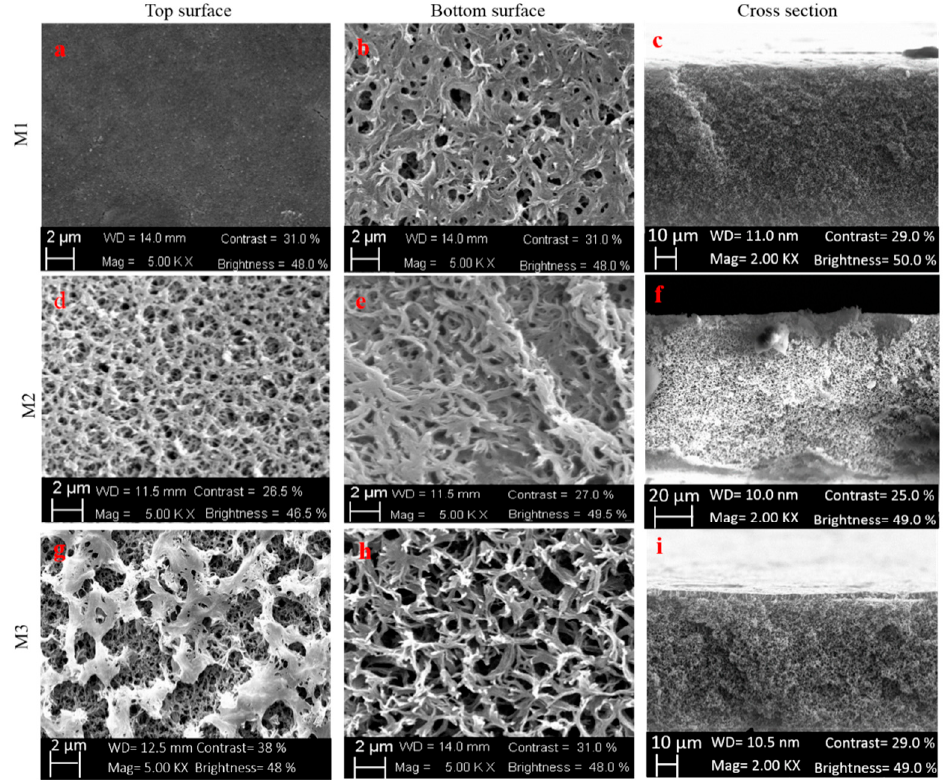
Figure 3. SEM images: top surface, bottom surface and cross-sections of membranes M1, M2, and M3.